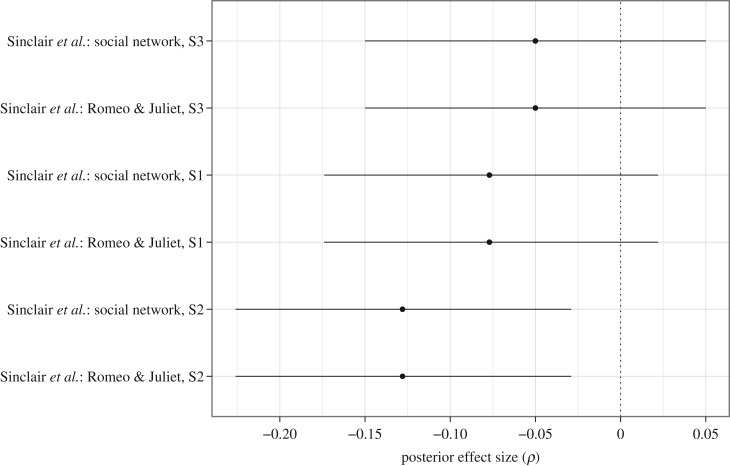
Individual Bayesian parameter estimation results for directed effect sizes ρ for each of six experiments reported in the Social Psychology special issue that used correlation tests. The posterior medians are indicated as dots and the central 95% credible intervals as vertical lines. The effect sizes were estimated using separate unrestricted models, but recoded such that they are predicted to be positive. Figure available at https://flic.kr/p/FqBRsm, under CC license https://creativecommons.org/licenses/by/2.0/.